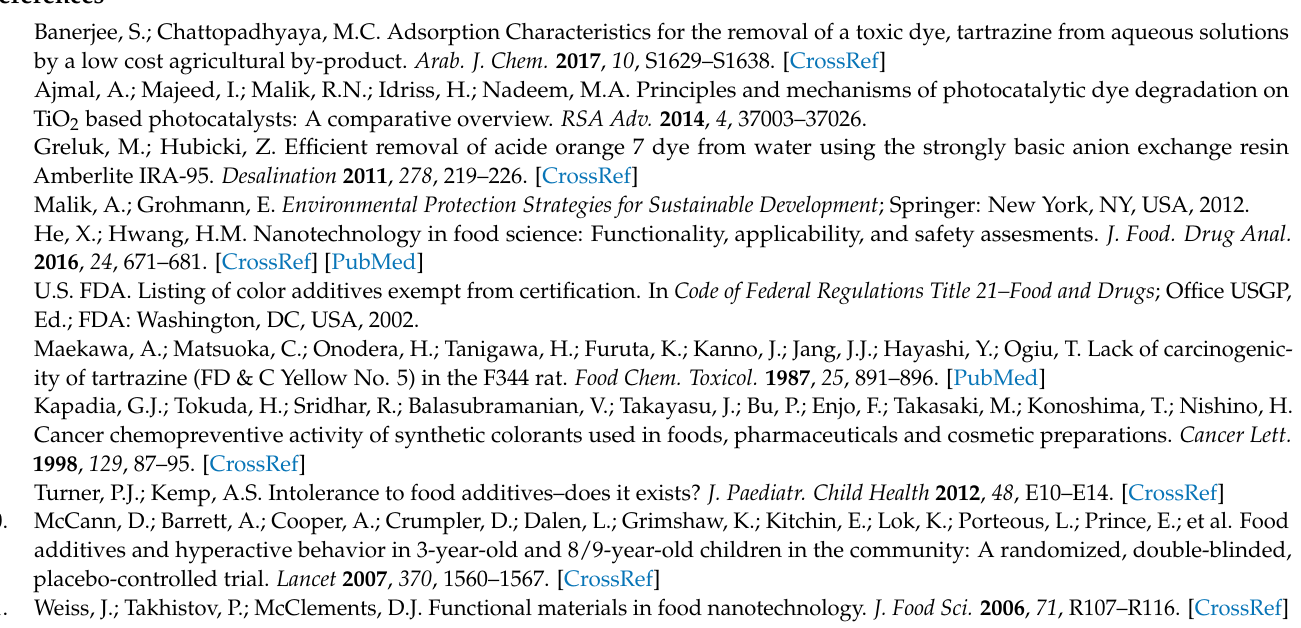
from Figure S10c. Initial concentration: 5ppm; Figure S11. Calibration curves for the